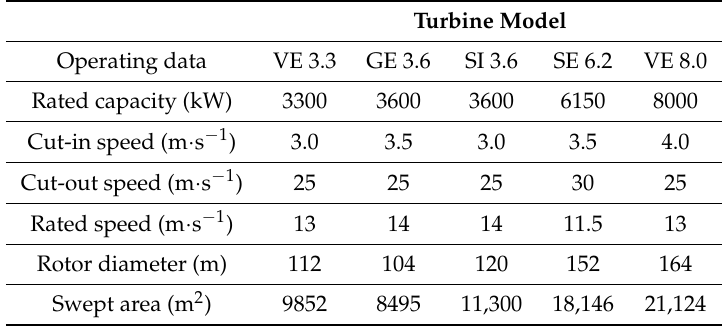
Table 1. Modern wind turbine characteristics. Vestas V112-3.3 MW (VE 3.3), General Electric 3.6s (VE